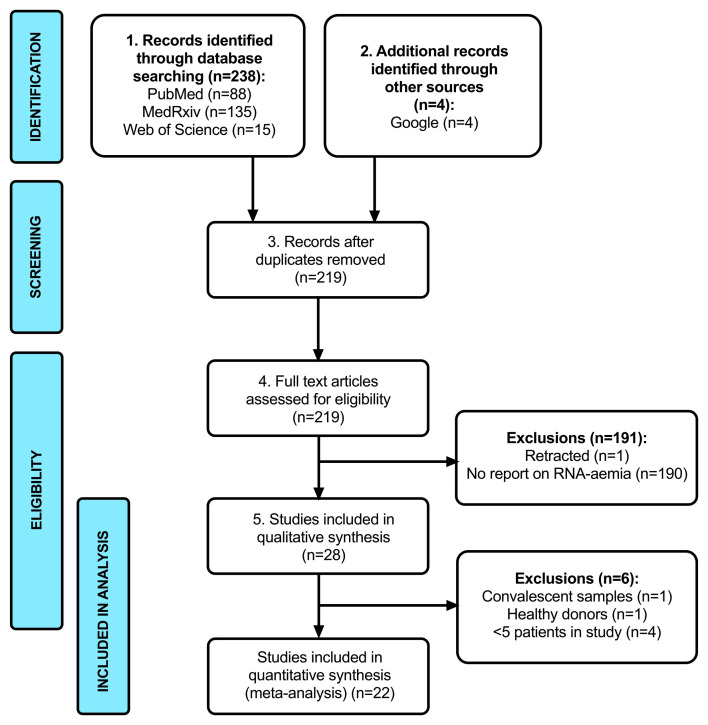
PRISMA flow diagram showing number of abstracts identified through a systematic literature review, rejections (with reasons), and final number of studies included in the analysis.